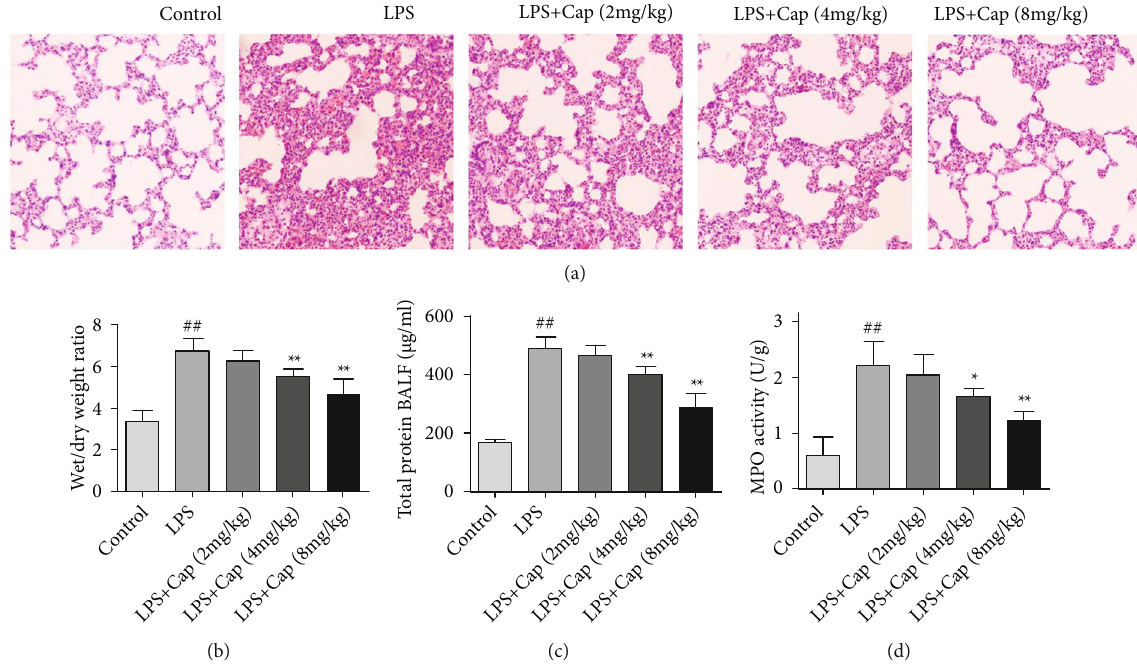
Figure 5: E ff ects of Cap on experimental pulmonary damage in the acute lung injury animal model. (a) Representative H&E staining (magni fi cation 200x) of lung tissues in each group. (b) The lung wet/dry weight ratio in each group. (c) Total protein levels in BALF. (d) The activity of MPO in lung tissues. Results are expressed as the mean ± standard deviation ( n = 8 ). ## P < 0 : 01 compared to the control group; ∗ P < 0 : 05 and ∗∗ P < 0 : 01 compared to the LPS